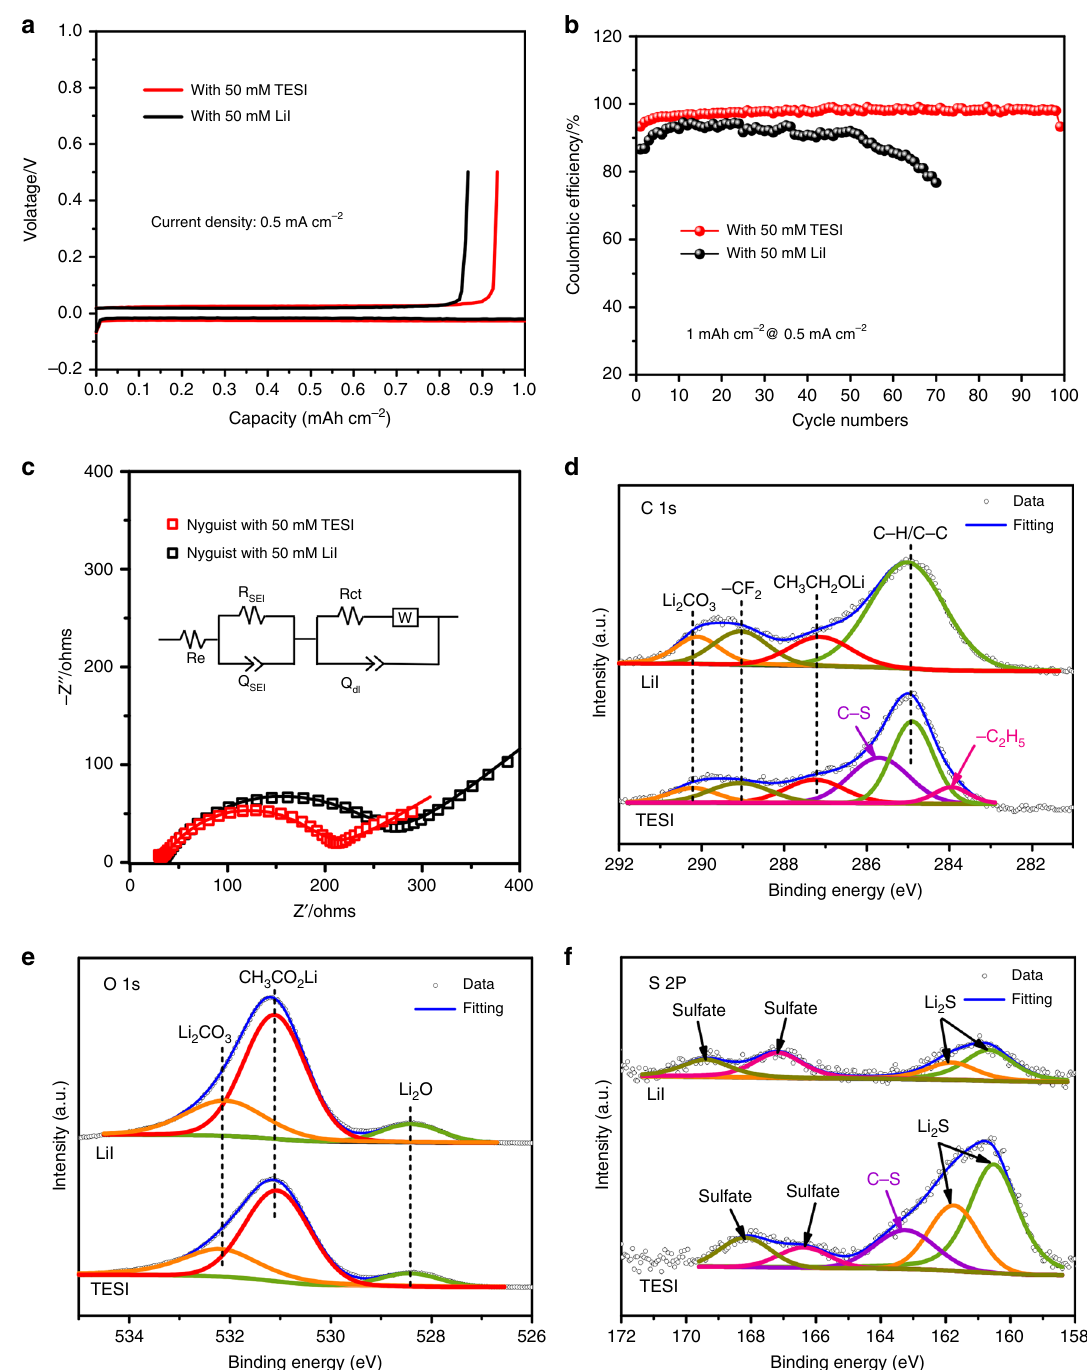
Fig. 7 Electrochemical performance and analysis of the Li anodes from Li | Cu cells in the presence of O 2 with a limited speci fi c capacity of 1 mAh cm − 2 . a Galvanostatic discharge/charge pro fi le at 0.5 mA cm − 2 . b Subsequent cycles, current density: 0.5 mA cm − 2 . c EIS of the Li | Cu cells after 100 cycles with 50 mM TESI or 50 mM LiI, and EIS analysis using an equivalent circuit model (shown in the inset). d – f XPS spectra of the Li anodes after 100 cycles with 50 mM TESI and 50 mM LiI